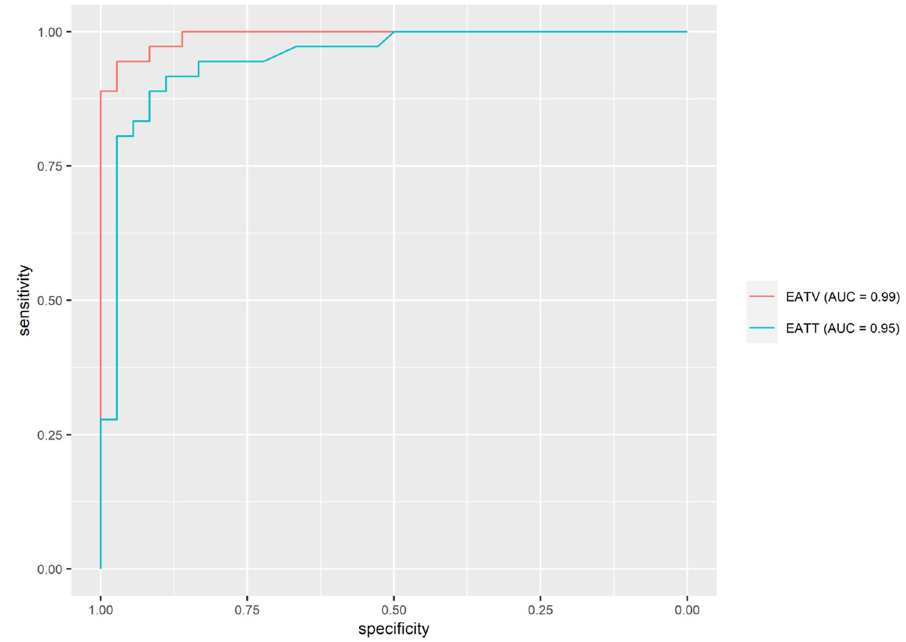
Figure 3. ROC curves and AUC for potential predictors of hypertension. EATT: epicardial adipose tissue thickness; EATV: epicardial adipose tissue volume. Table 3. Predictors of hypertension.